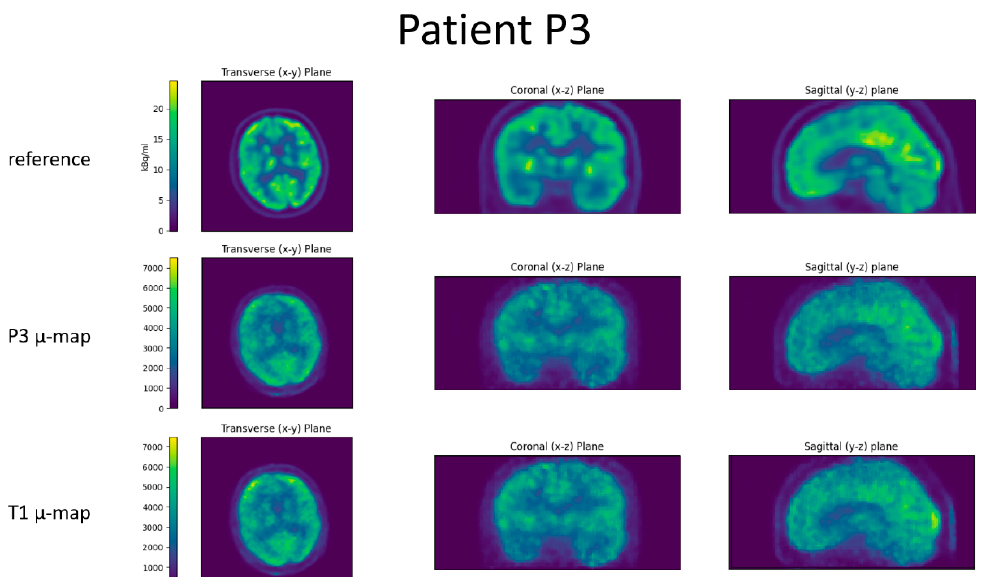
Figure 8. Slices through the reconstructed images for patient P3. Top row is the reference PET scan, middle row the BPET reconstruction using the patient-specific µ-map (from CT of patient P3), bottom row the BPET reconstruction using an independent template µ-map fitted with the method presented in this article.